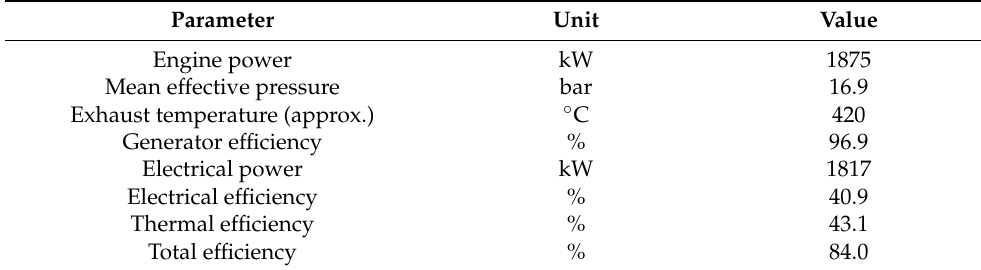
Table 1. General specifications of TBG 620V gas engine